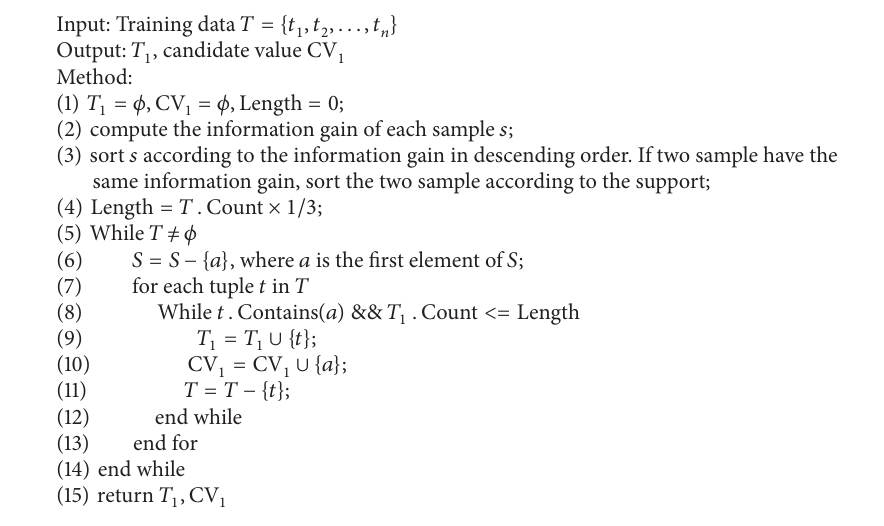
Algorithm 1: Dividing training set into three